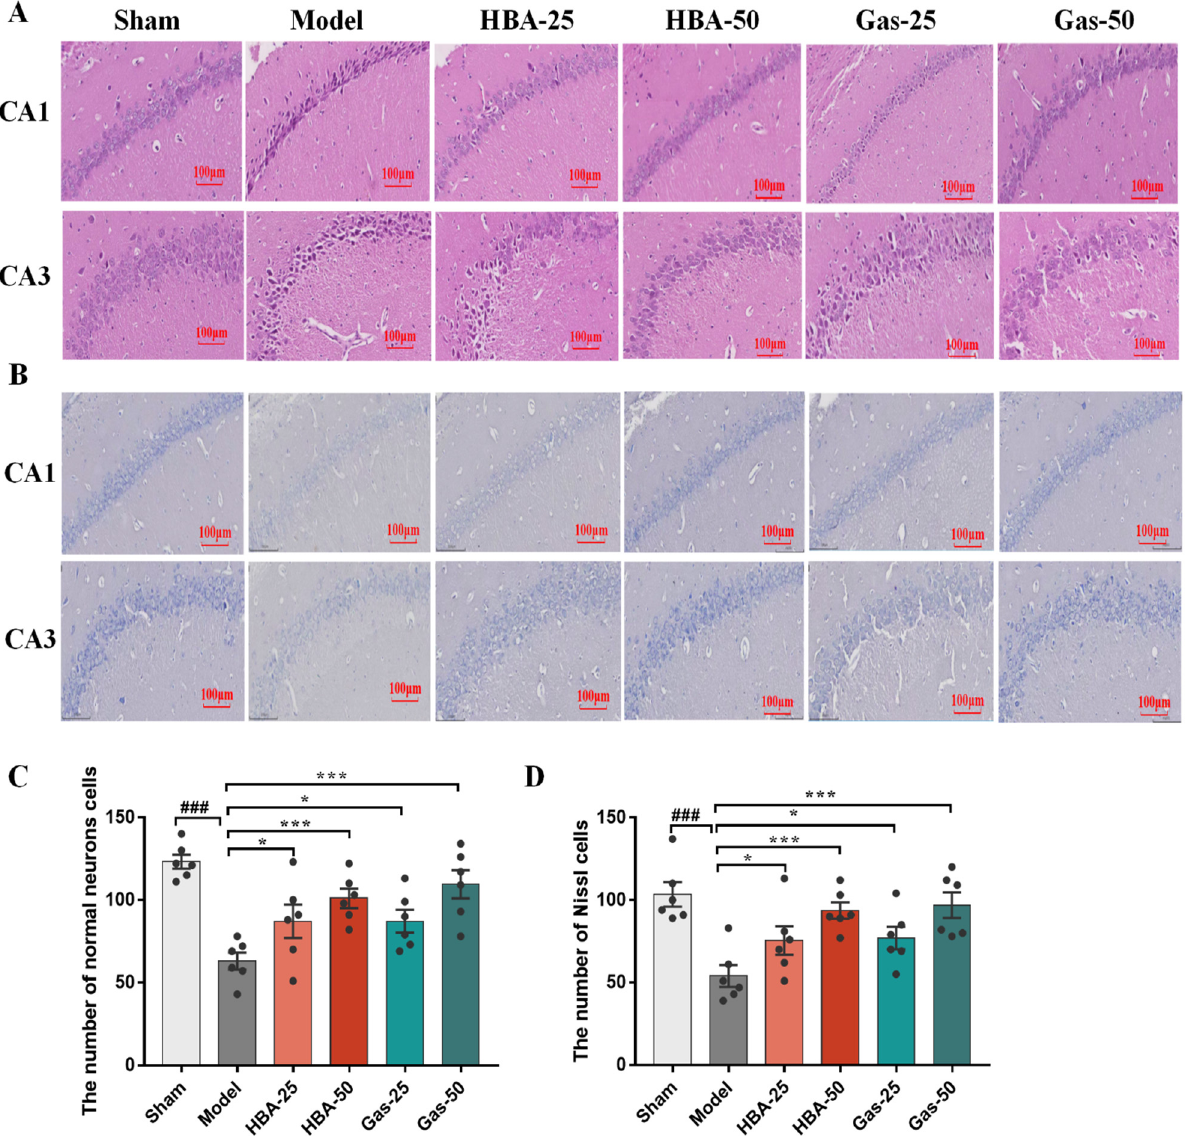
Figure 2. Effect of Gas and HBA on 2-VO-induced morphological changes of neuronal cells in CA1 and CA3 regions of the hippocampus. ( A ) Representative pictures of H&E staining to observe the morphology of hippocampal neurons; ( B ) Representative micrographs of Nissl staining experiments. ( C ) Quantitative graph of H&E staining; ( D ) Quantitative graph of Nissl staining. 200 × magnification, scale bar = 100 μ m. Arrows point to the nuclear chromatin condensation. Values are expressed as means ± SEM. ### p < 0.001 vs. Sham, * p < 0.05, *** p < 0.001 vs. Model.